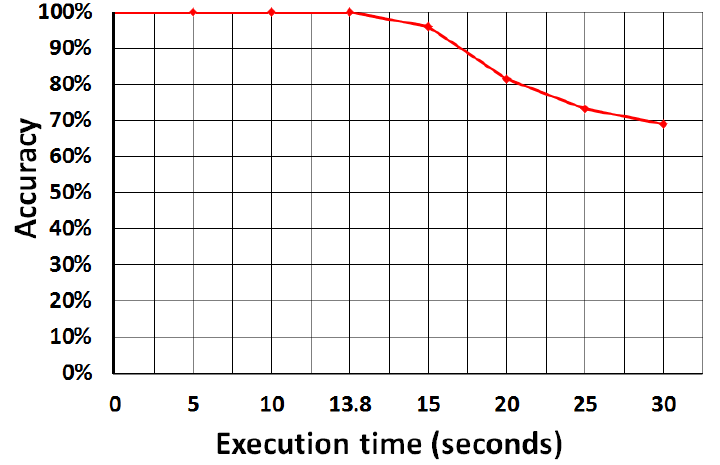
Figure 4. Analytic analysis of energy model